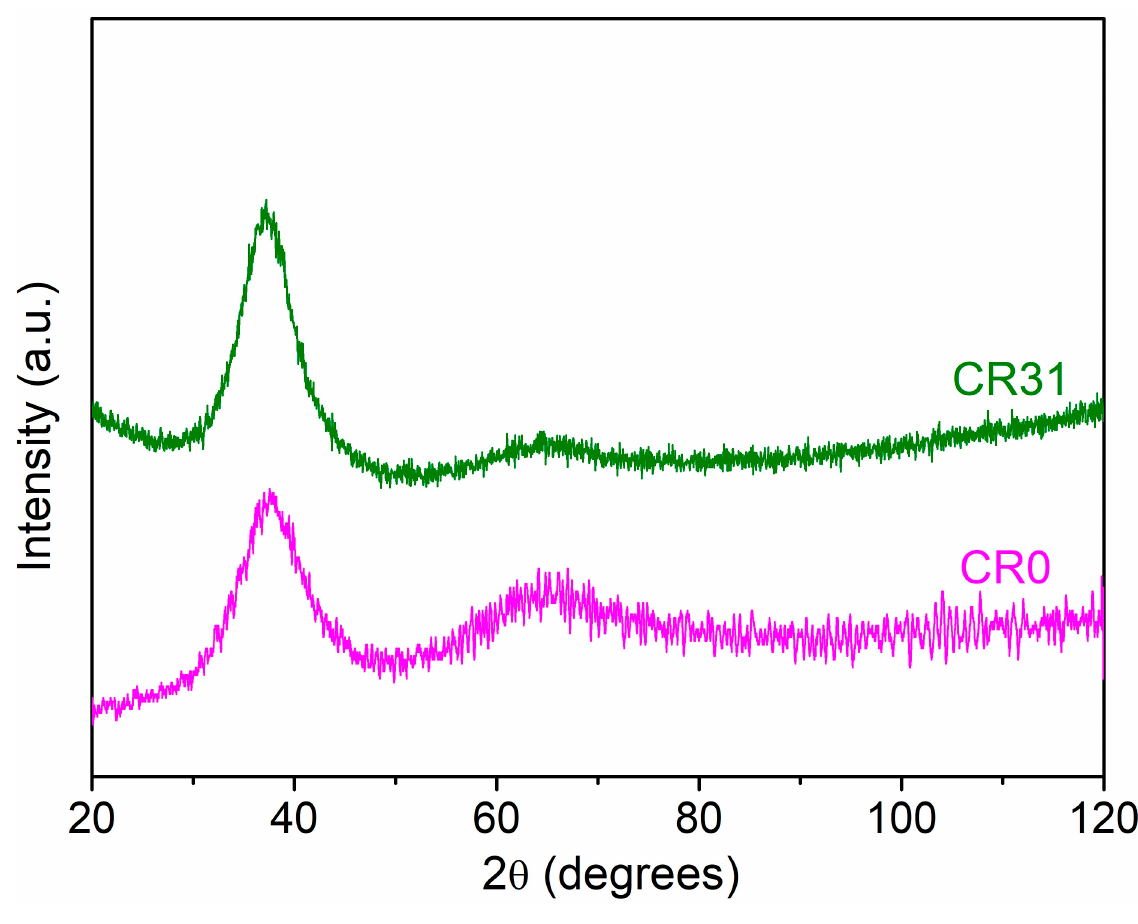
Figure 2. X-ray diffraction (XRD) patterns of CR0 and CR31 showing amorphous humps confirming the glassy nature of the samples.